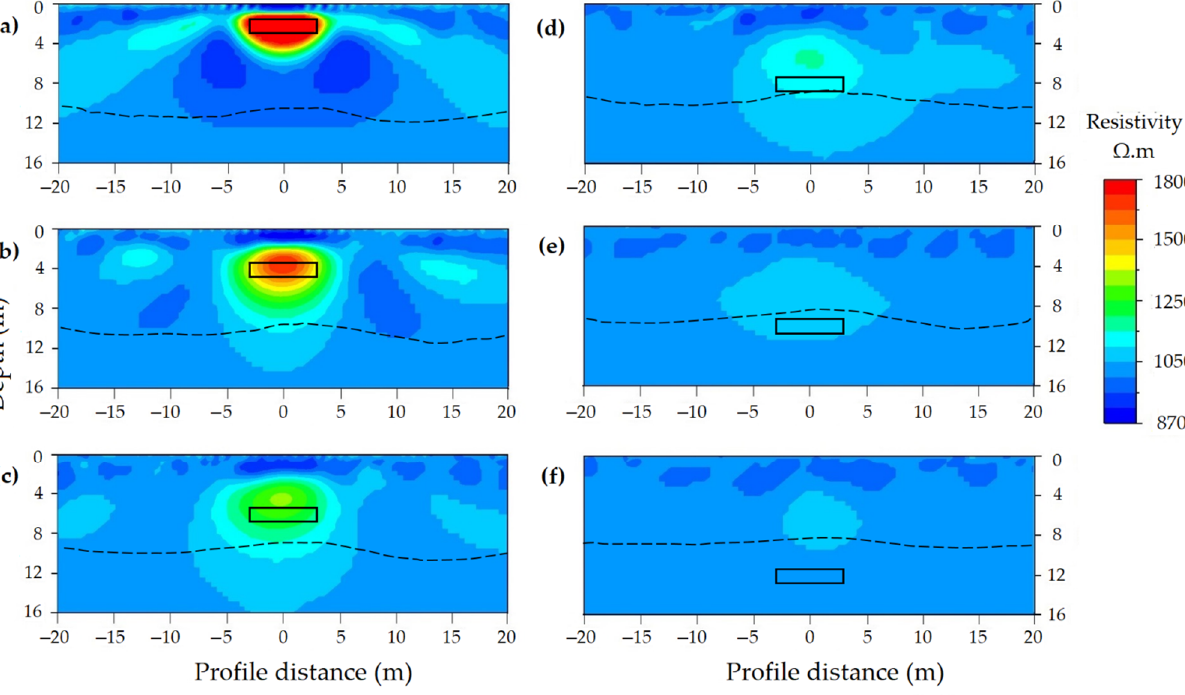
Figure 9. Inverted resistivity model using Wenner–Schlumberger (WS) array for the cavity targets: ( a ) T 1 , ( b ) T 2 , ( c ) T 3 , ( d ) T 4 , ( e ) T 5 , ( f ) T 6 . The rectangular boxes indicate the actual air-filled cavities. The broken lines represent the DOI threshold depths.